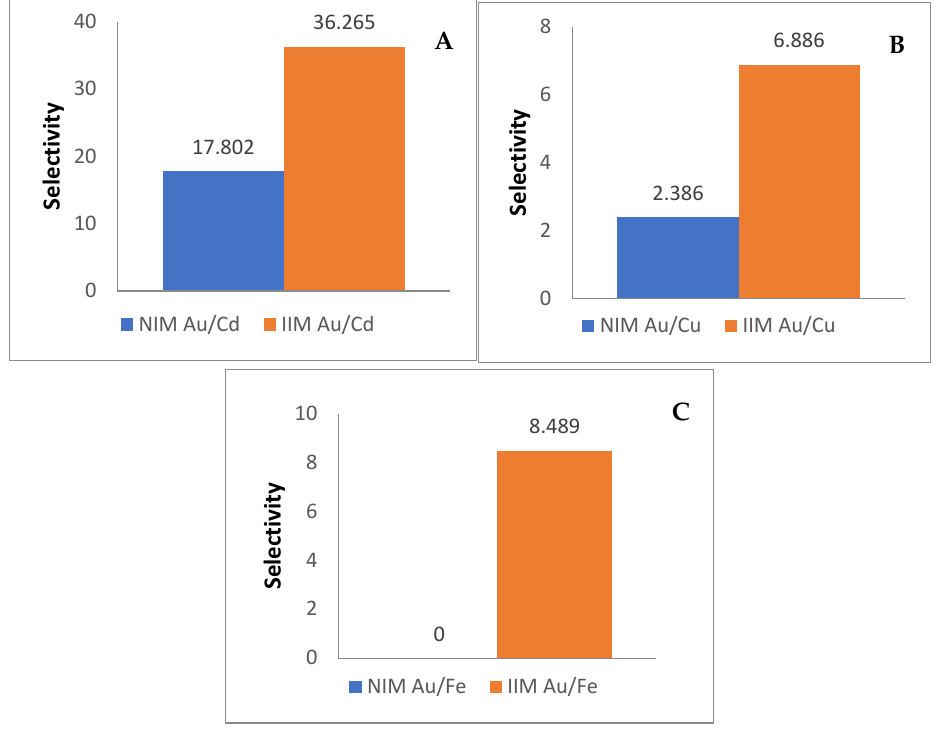
Figure 11. Selectivity of NIM and IIM in ( A ) Au/Cd ( B ) Au/Ce ( C ) Au/Fe mixture solution.